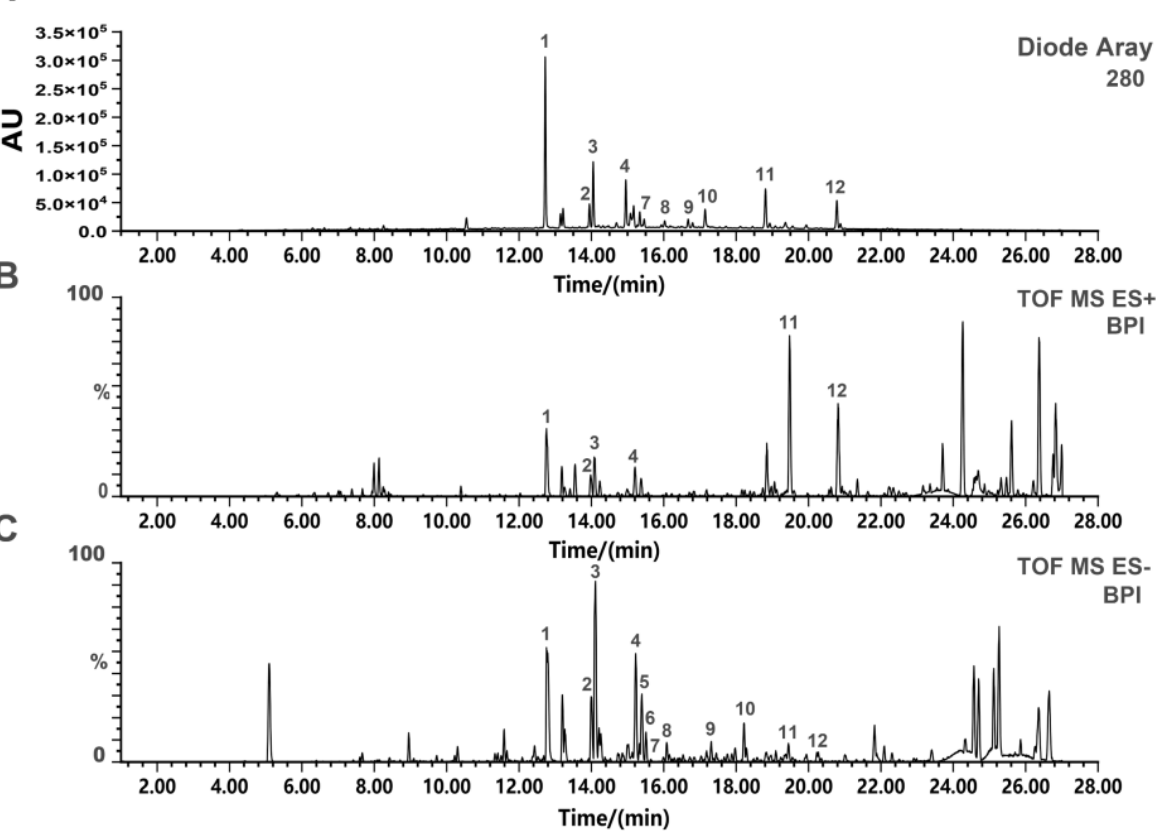
Figure 1. UPLC-Q-TOF-MS analysis of SD-BFRE. ( A ) The basic peak intensity (BPI) chromatograms of SD-BFRE from UPLC-QTOF-MS analysis in the ultraviolet mode. ( B ) Chromatograms in the positive ion mode of SD-BFRE. ( C ) Chromatograms in the negative ion mode of SD-BFRE. Table 1. Identification of biflavonoid from SD-BFRE by UPLC-QTOF-MS.